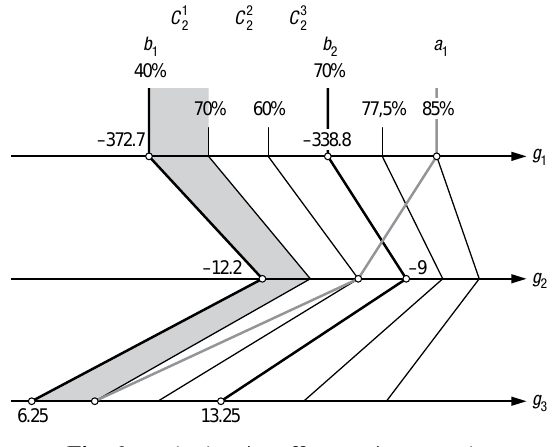
Fig. 6. Assigning the offer to